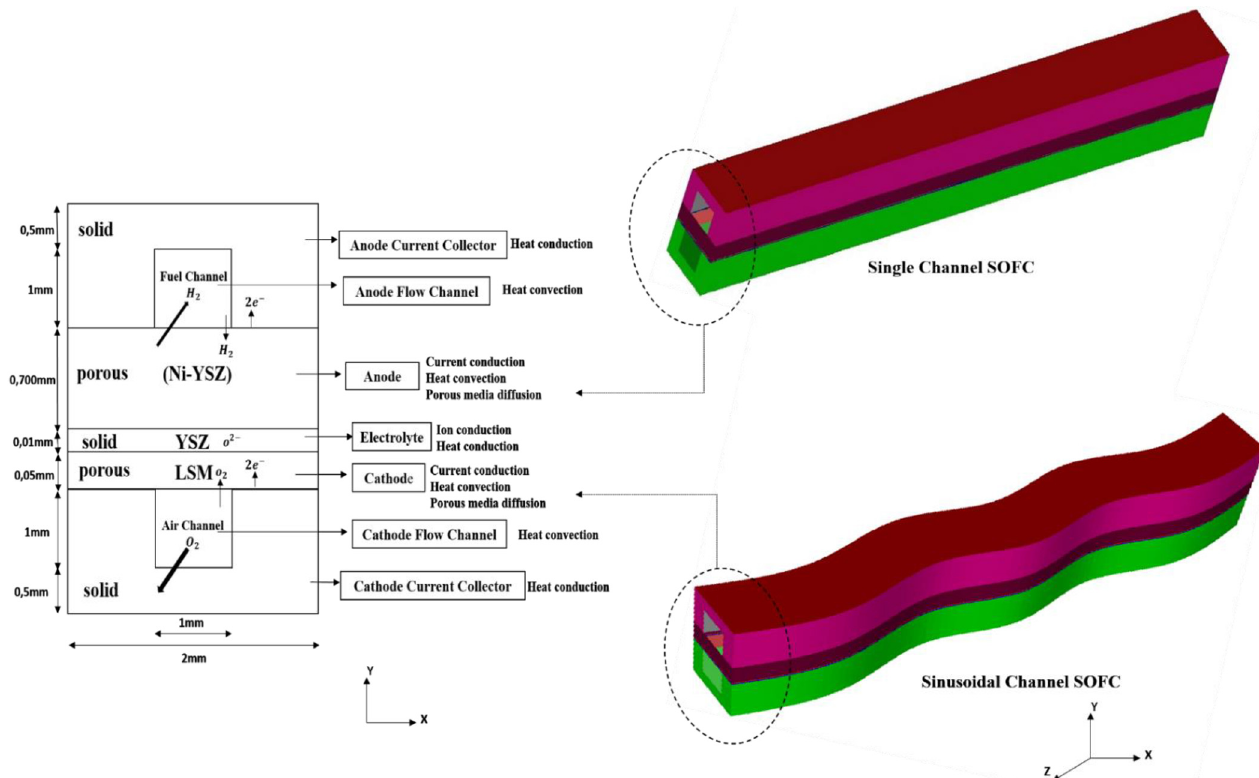
Fig. 1. Schematic view of SOFC with two different fl ow designs.